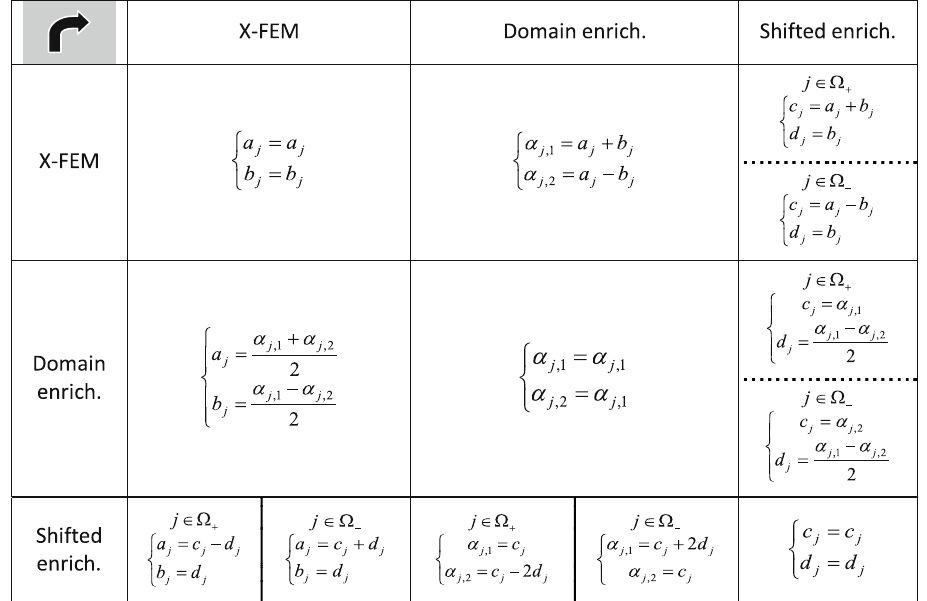
Table 2 Change of variables when switching enrichment strategies. ∀ j ∈ I H , the following changes of variables